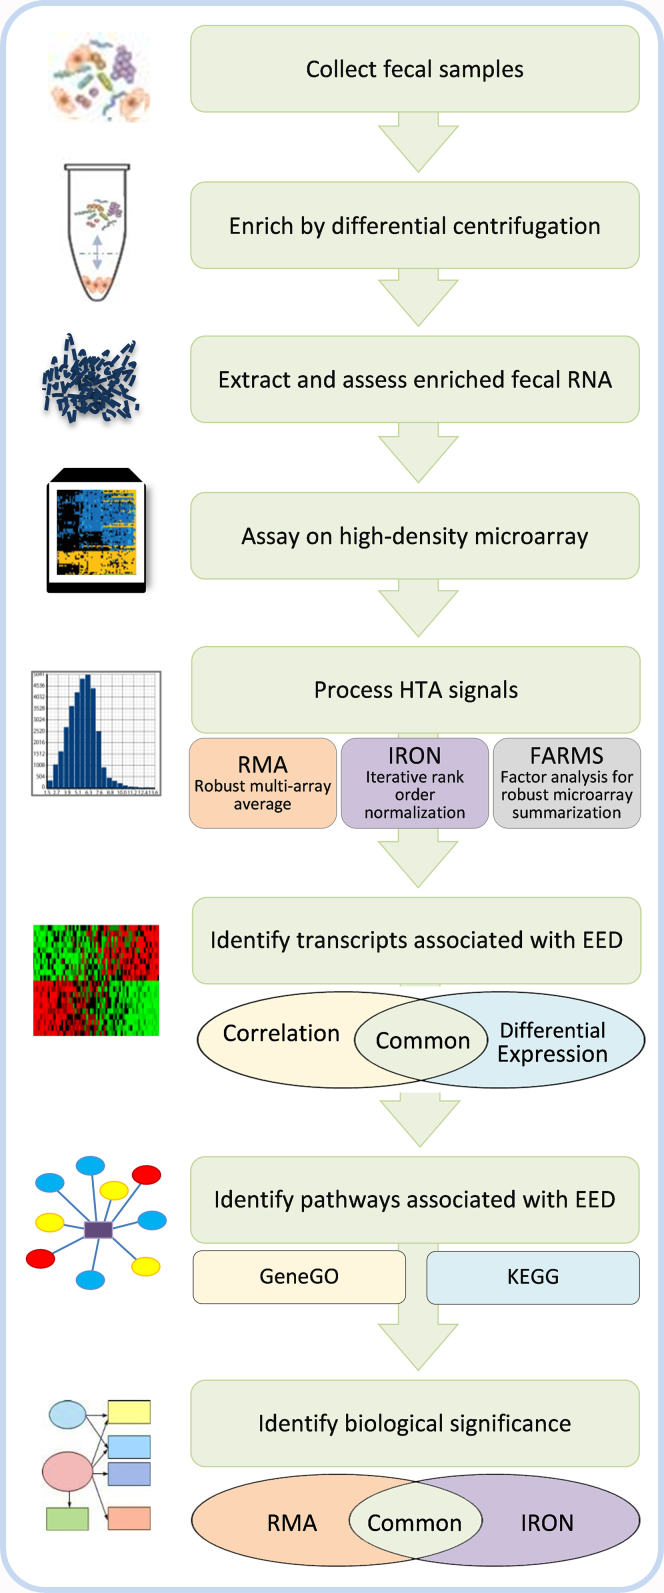
Schematic flow chart of human fecal transcriptome analysis. Fecal samples were collected fresh from subjects, immediately flash-frozen in liquid nitrogen, and transported to the laboratory. In the laboratory the cells were suspended in buffer with inert beads and centrifuged at 500g. The resulting pellet was kept, resuspended in lysis buffer, and used for total nucleic acids extraction. DNase was added to the nucleic acids mixture, and RNA was separated from the suspension using a bead-based affinity method. The RNA then was amplified and hybridized to a chip containing 25mers covering the entire human genome. The signals corresponding to luminescence for each 25mer were aggregated into genes, and normalized using 3 standard methods. Those transcripts that showed significant correlation with %L, a marker of EED, and differential expression with subsets of increased and normal %L were identified. All transcripts then were used to determine pathway expression for all canonical and KEGG pathways. Transcripts that were correlated with %L, differentially expressed between children with no EED and severe EED, and present in pathways also associated with EED were considered to be of biological significance for EED. HTA, Human Transcriptome Array 2.0 (Affymetrix).